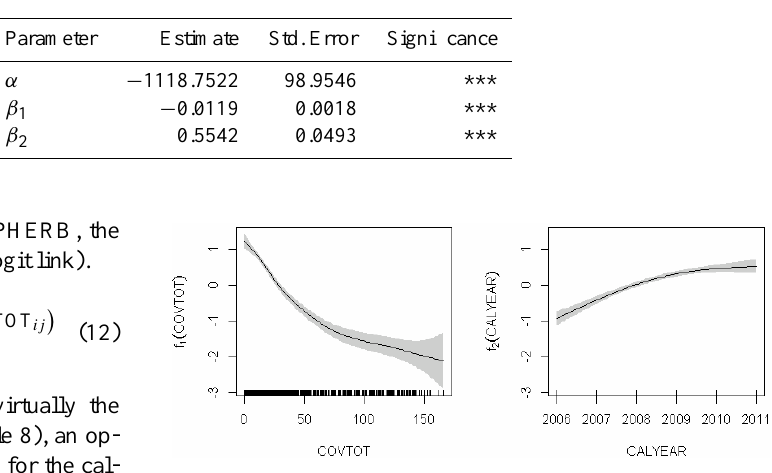
Table 10. Parameter estimates and significances for the model estimating the proportion of woody plants (PROPWOOD) as shown in Eq. (14). Significance levels: ***: p < 0.001, **: p < 0.01, *: p < 0.05. The variance of the random effect a in Eq. (14) is 3.1987. Trend: qualitative illustration of linear predictor variables’ significant influences. ↑ , ↓ : PROPWOOD increases (decreases) with increasing values of the respective predictor variable.